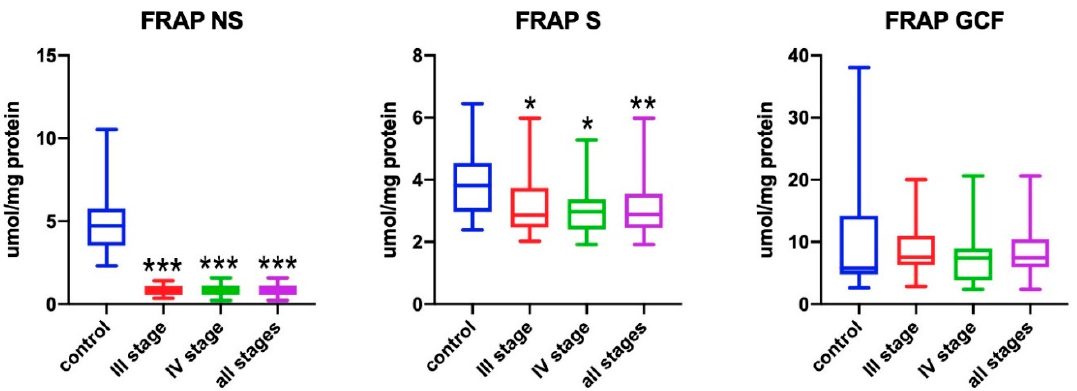
Figure 4. Concentrations of ferric ion reducing antioxidant power (FRAP) in non-stimulated saliva (NS), stimulated saliva (S), and gingival crevicular fluid (GCF) in all patient groups. * p < 0.05, ** p < 0.01, *** p < 0.001 vs. control group.